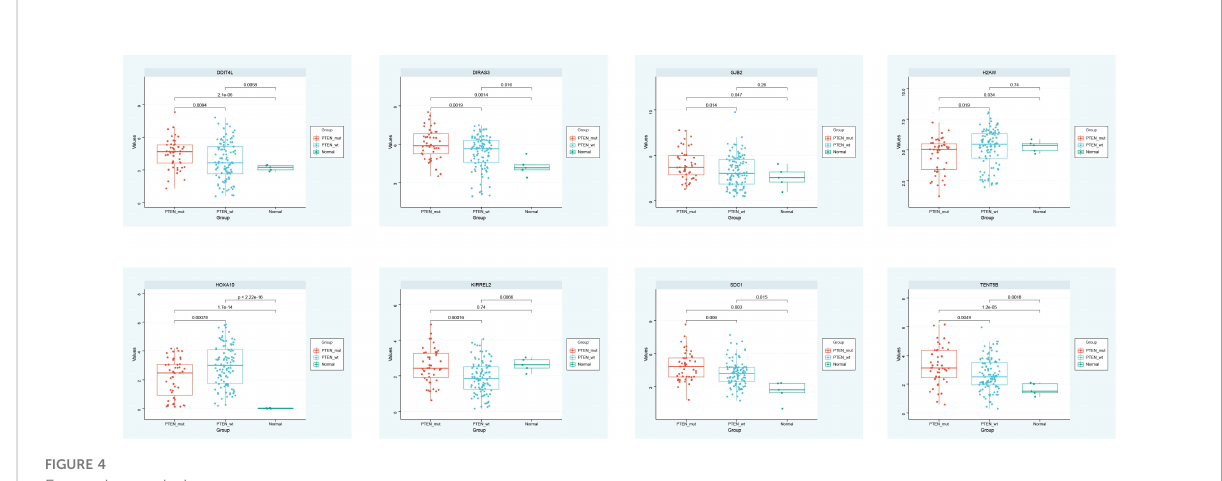
FIGURE 4 Expression